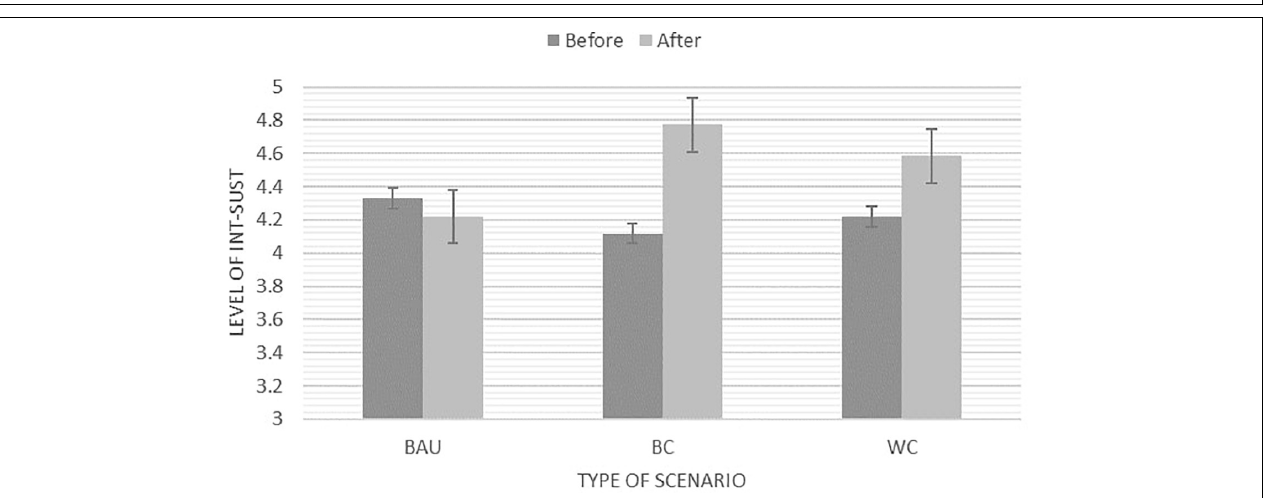
FIGURE 4 | Example of the Best Case Scenario drawing, converted into a mural painting in Taytay town after the study was conducted.